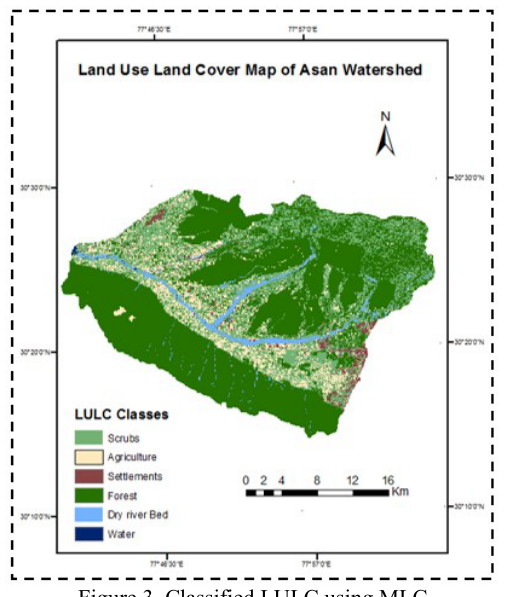
Figure 3. Classified LULC using MLC